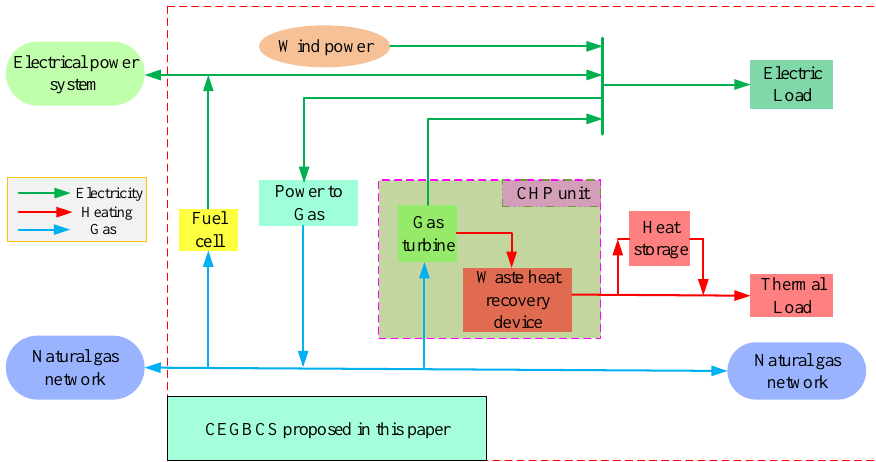
Figure 2. Composition of gas – electric bidirectional conversion system.